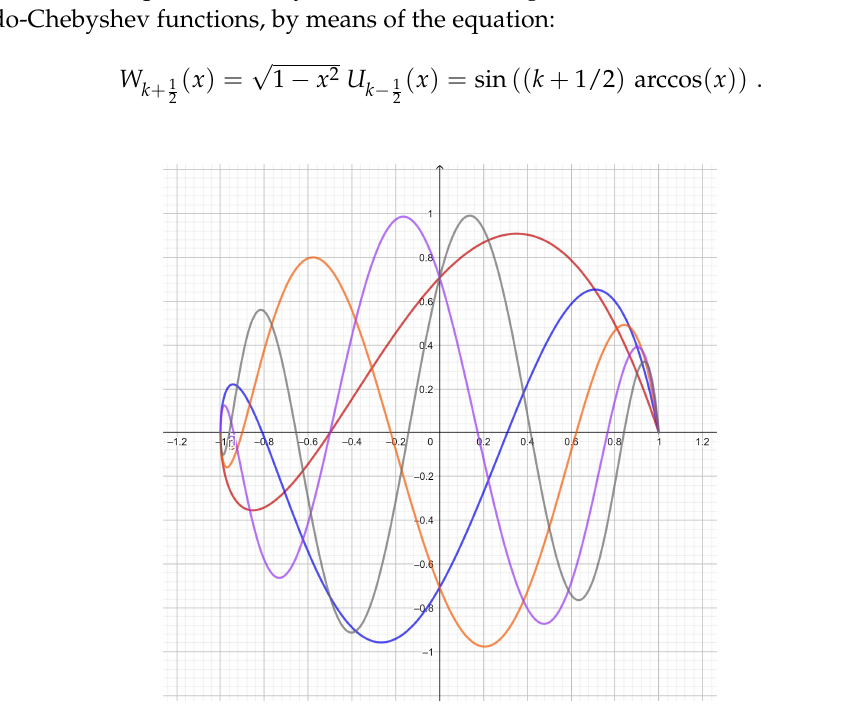
Figure 6. W k + 1/2 , k = 1,2,3,4,5. 1, red; 2, blue; 3, orange; 4, violet; 5,